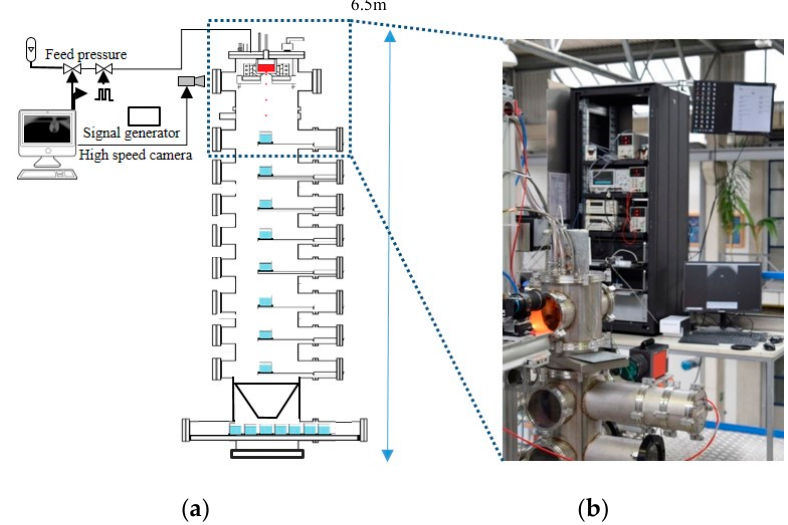
Figure 5. ( a ) Schematic view of high temperature drop-on-demand droplet generator; ( b ) the top part of the tower during the experiment showing the three top windows of the plant, high-speed camera and controlling systems.